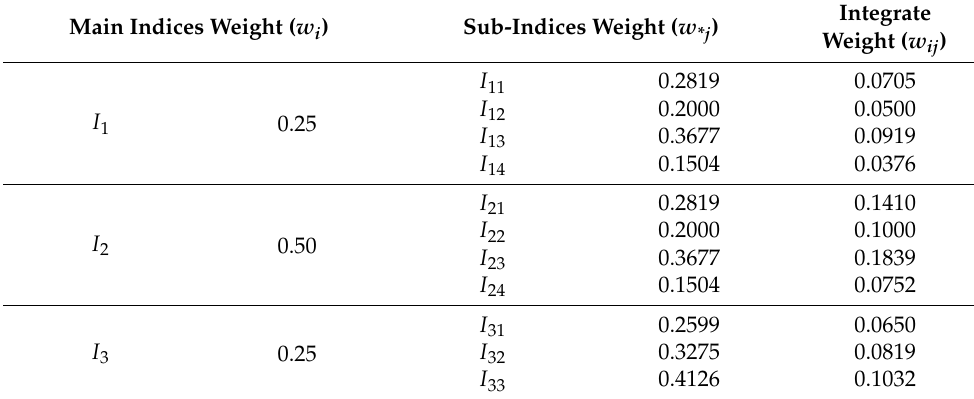
Table 6. The individual and integrate weights of indices.